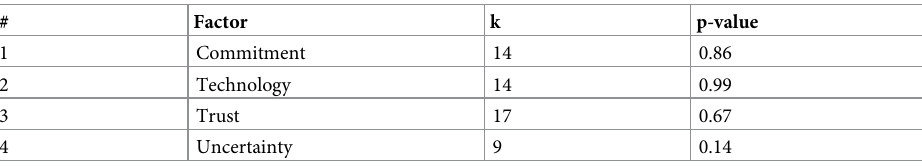
Table 3. Publication bias